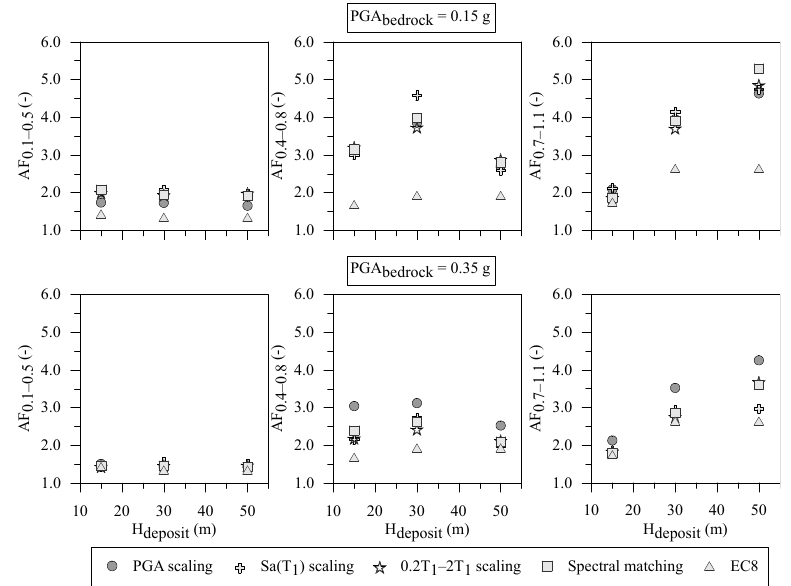
Figure 8. Mean values of AFs for a deposit thickness equal to 15, 30, and 50 m, and V S2 (z), considering 4 input motions selection strategies. EC8 values for 15, 30, and 50 m refer to ground types E, D, and D, respectively.